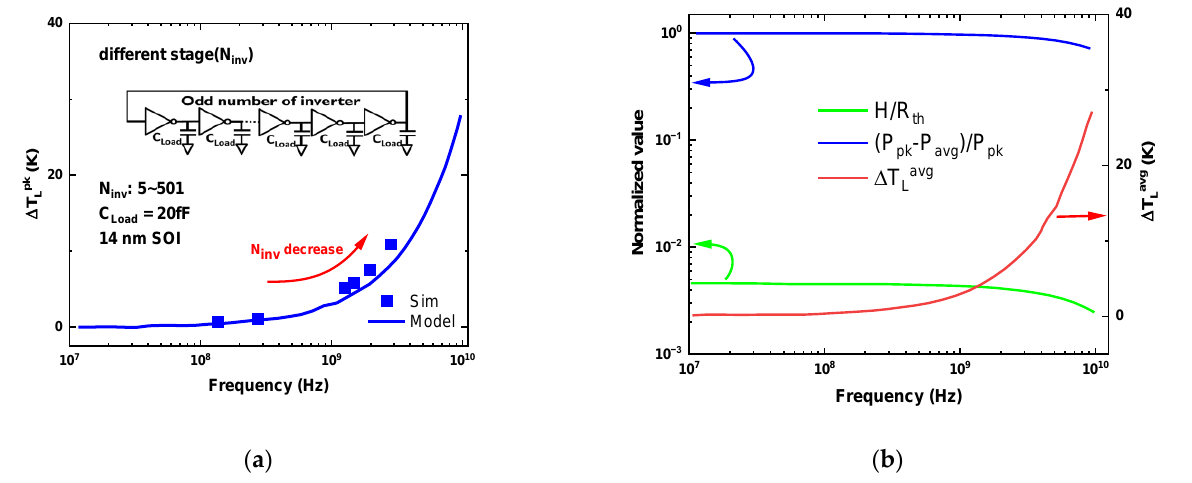
Figure 5. ( a ) The peak self-heating temperature increases as the oscillation frequency increase, ( b ) The explanation of ( a ) [28].